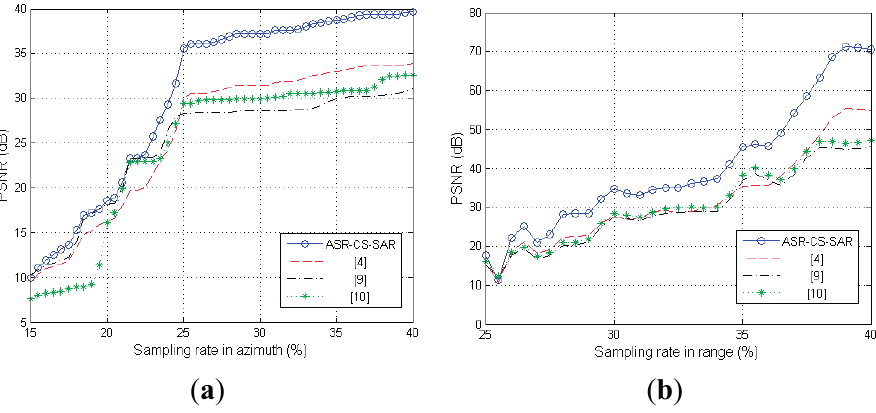
Figure 6. Comparison of the reconstruction performance. ( a )33% sampling rate in range; ( b ) 25% sampling rate in